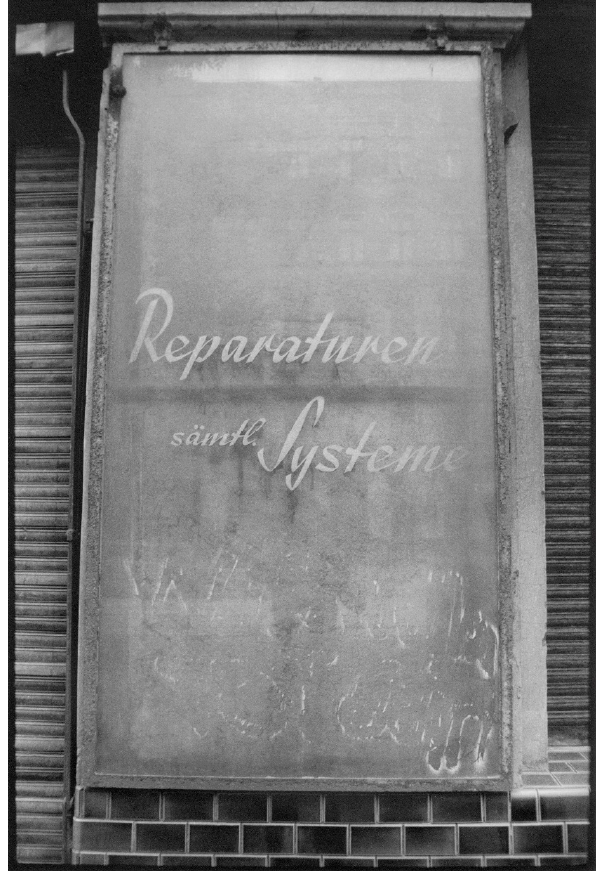
Figure 7. Harald Hauswald, Werbetafel eines Nähmaschinenladens, Pappelallee, Berlin-Prenzlauer Berg (Advertising board of a sewing machine shop, Pappeallee, Berlin-Prenzlauer Berg), 1984. Photo Credits: Ostkreuz–Agentur der Fotografen/Harald